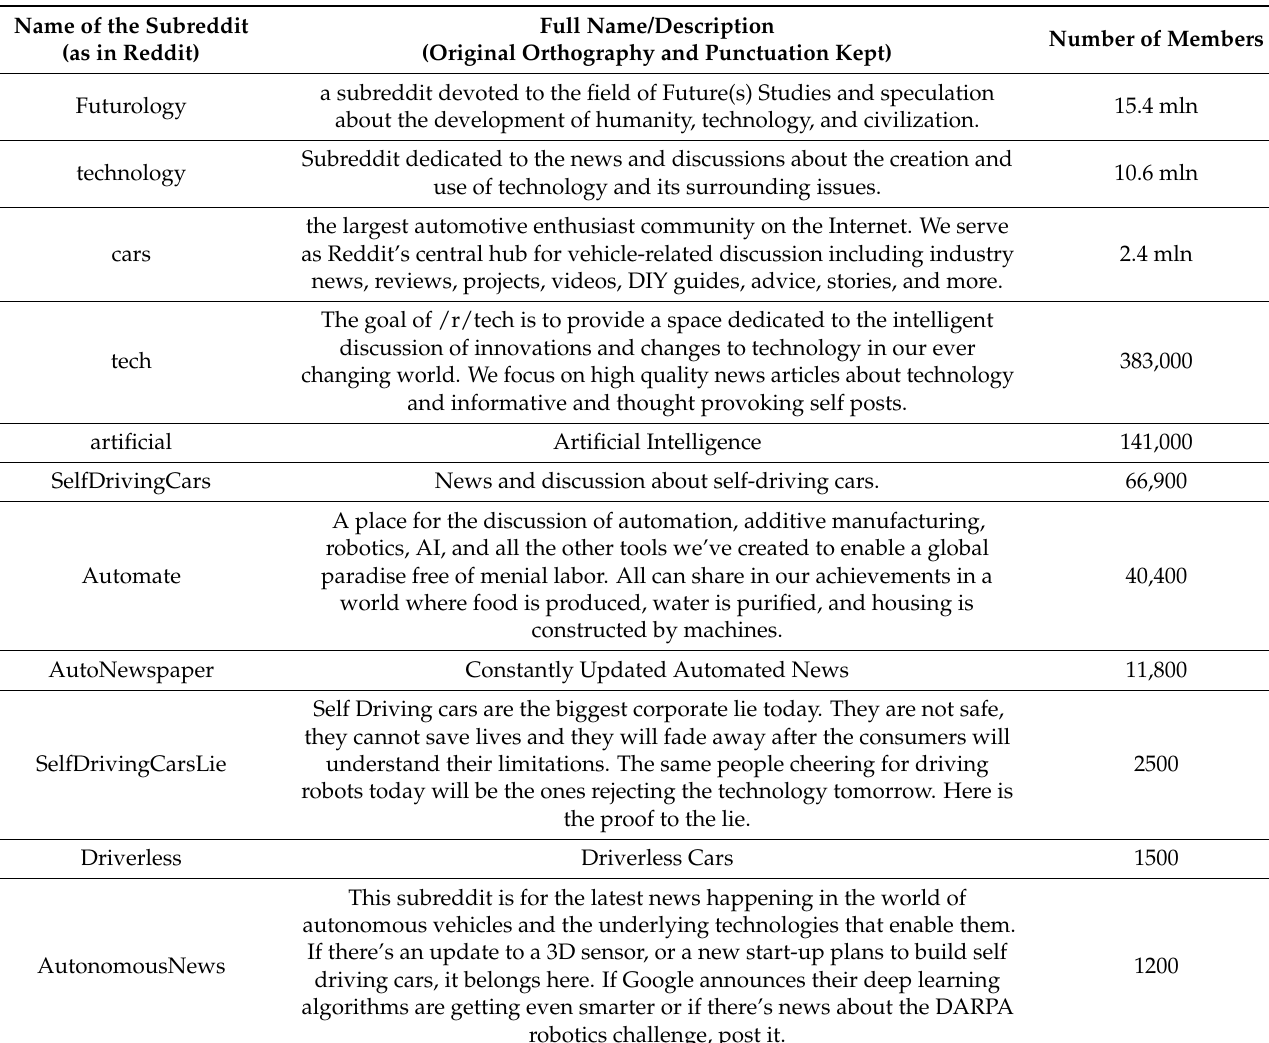
Table A1. List of the ITS